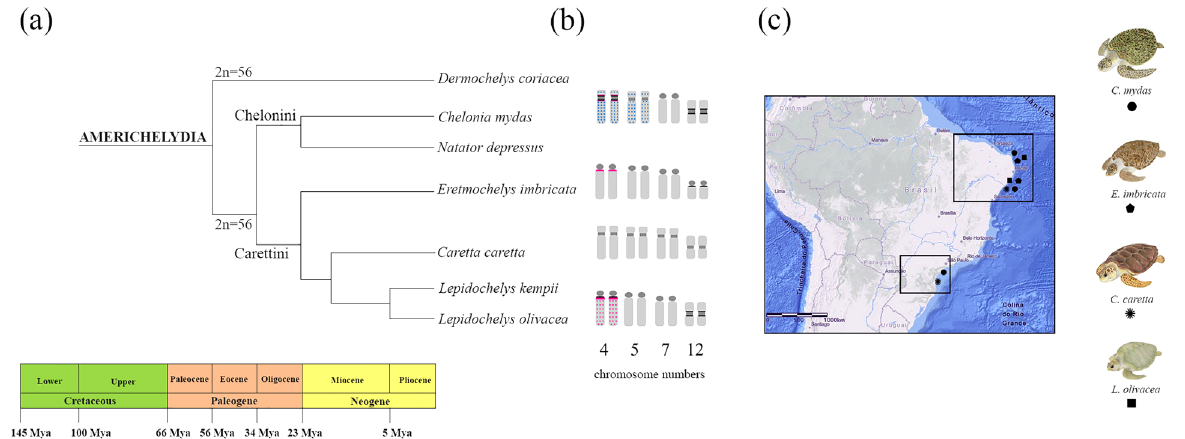
Figure 1 – Phylogeny, sampled area, and details of chromosome changes in four Cheloniidae species: In (a) phylogeny and ancestral reconstruction of sea turtle species adapted from Pereira et al . (2017); In (b), representative idiograms of the pairs 4, 5, 7 and 12 involved in chromosomal changes among sea turtle species; and (c) partial map of South America showing sea turtles sampled in different places in the Brazil and referred by geometric forms, C. mydas (circle), E. imbricatta (pentagon), C. caretta (asterisk), and L. olivacea (square). Images of sea turtles (Source: Projeto Tamar).